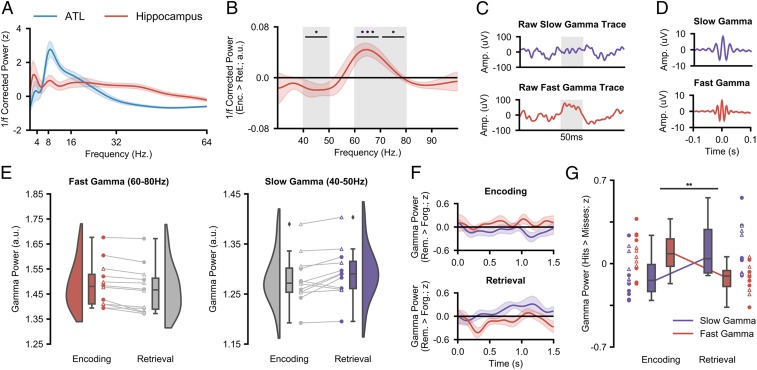
Hippocampal gamma activity during encoding and retrieval. (A) The mean 1/f–corrected power spectrum (with shaded SEM) across all encoding and retrieval trials reveals theta and gamma peaks in the hippocampus and an alpha/beta peak in the ATL. (B) The mean difference in gamma power (with shaded SEM) between encoding and retrieval reveals a peak in encoding-related, fast gamma at 60 to 80 Hz and a peak in retrieval-related, slow gamma at 40 to 50 Hz (*Pfdr < 0.05, ***Pfdr < 0.001). (C) Raw slow gamma signal during retrieval (Top) and fast gamma signal during encoding (Bottom) from a hippocampal contact of participant 1. The shaded gray regions indicate a period of 50 ms. (D) Mean peak-locked averaged signal across participants for slow (Top) and fast (Bottom) gamma (with shaded SEM). (E) Raincloud plots depicting the difference in fast (Left) and slow (Right) gamma power between encoding and retrieval. Colored circles represent participants who took part in experiment 1. Uncolored triangles represent participants who took part in experiment 2. (F) Time series of slow (in purple) and fast (in red) memory-related gamma power for encoding and retrieval. (G) Interaction between fast and slow gamma activity during encoding and retrieval. Encoding sees a relative increase of memory-related fast gamma power, while retrieval sees a relative increase of memory-related slow gamma power (**Pfdr < 0.01).